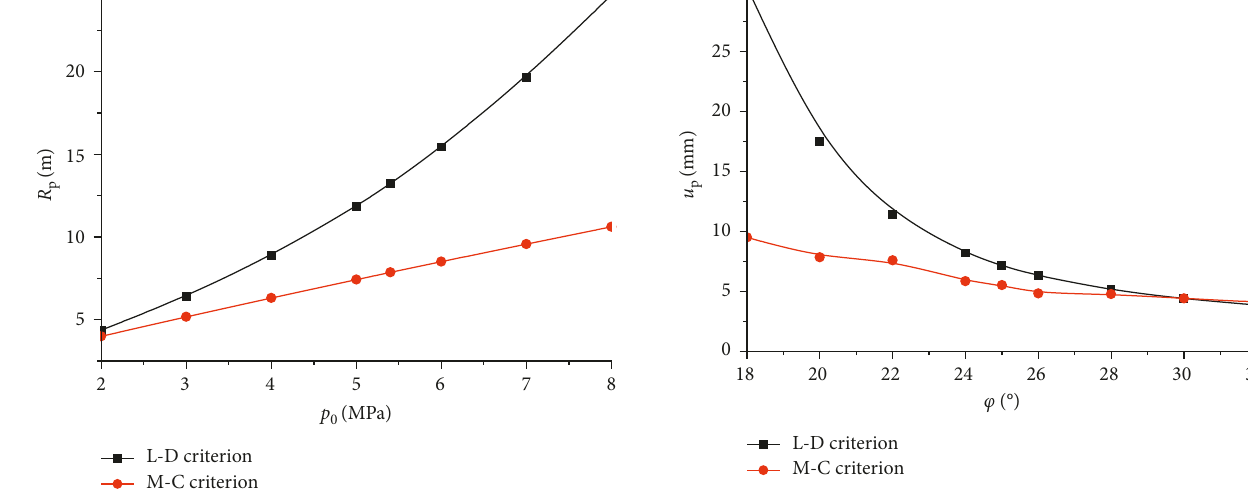
Figure 6: Relation curves between internal friction angle and plastic zone displacement.